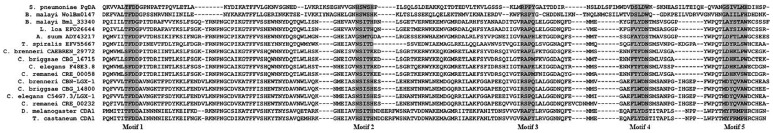
Alignment of protein sequences spanning the polysaccharide deacetylase domain (Nod B homology domain) for some newly identified nematode polysaccharide deacetylases and representative sequences from bacteria and insects.The catalytic domain of this family of enzymes has been previously characterized by the inclusion of five motifs essential for activity. Motifs 1 and 2 contribute residues necessary for co-factor binding; Motifs 1, 3, 4 and 5 contribute residues essential for acetyltransferase activity [13], [14], [15]. All five motifs are conserved in nematode PDAs. Some residues are highly conserved among nematodes but differ from the canonical residues observed in bacterial and/or insect sequences. In general, nematode sequences are more similar to the other metazoan homologs from insects – with large stretches of identity observed among nematode and insect sequences even outside the motifs. Our identified sequence WolBm0147, derived from Wolbachia sp. TRS, is more similar to the representative bacterial sequence from Streptococcus pneumoniae supporting a bacterial origin of this sequence.